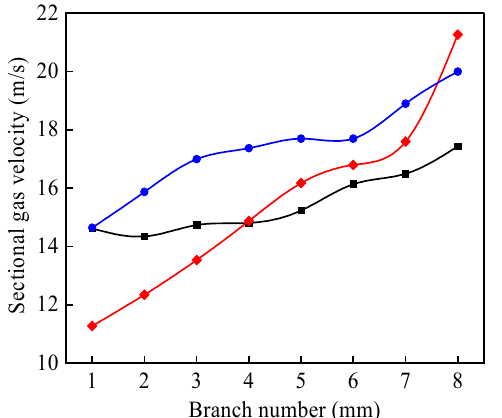
Figure 8. Sectional gas velocities at the airflow outlets from branch pipes in the bench and simulation tests. Red curve: simulation test without the airflow equalisers. Black curve: simulation test with the airflow equalisers. Blue curve: bench test with the airflow equalisers.